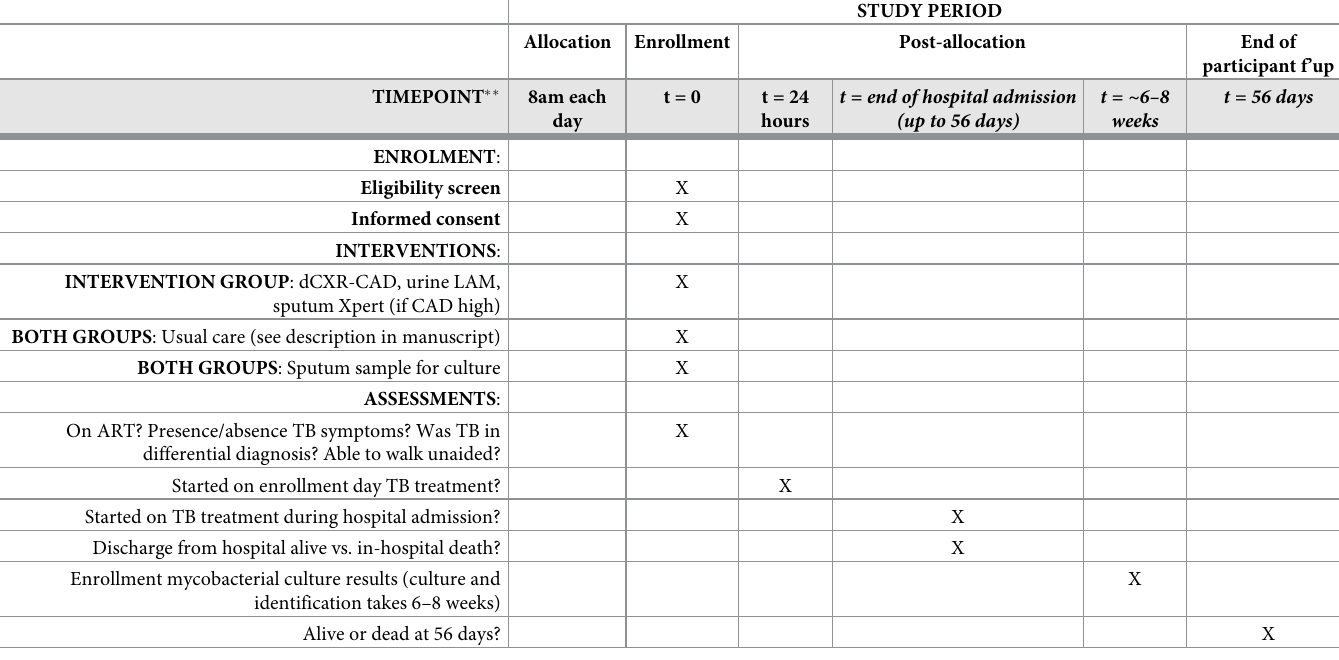
Table 1. CASTLE trial schedule (SPIRIT